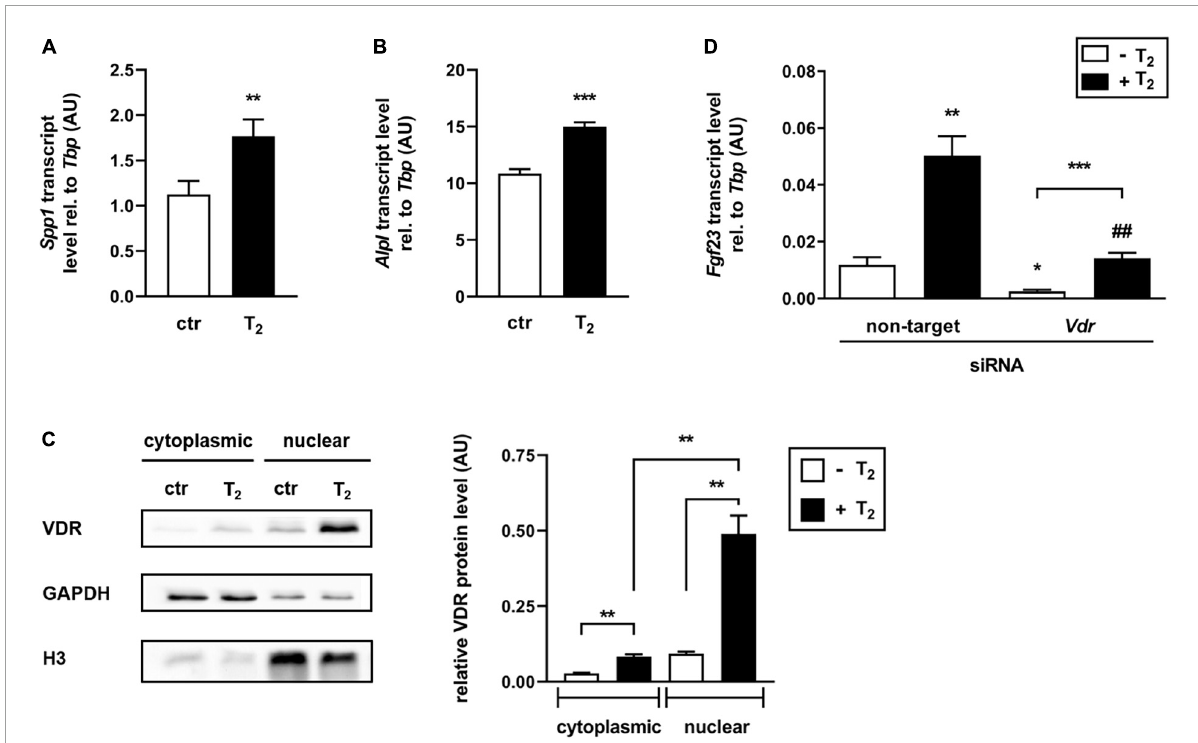
FIGURE3 The effect of tachysterol 2 on Fgf23 expression depends, at least in part, on regulation of the vitamin D receptor. Arithmetic means ± SEM of relative (rel.) Spp1 ( A n = 6) or Alpl ( B n = 5) mRNA abundance (normalized to Tbp ) in UMR106 cells treated with 25 µ M tachysterol 2 (T 2 ) for 24 h. (C) Original Western blots (left panel) showing cytoplasmic and nuclear VDR, GAPDH, and histone H3 (H3) protein abundance in UMR106 cells treated without (ctr) or with T 2 (25 µ M, 24 h). The right panel depicts the densitometric analysis (arithmetic mean ± SEM, n = 6) of cytoplasmic VDR (normalized to loading control GAPDH) and nuclear VDR (normalized to loading control histone H3) abundance in UMR106 cells treated without (white bars) or with (black bars) T 2 (25 µ M, 24 h). (D) Arithmetic means ± SEM of rel. Fgf23 mRNA abundance (normalized to Tbp ) in UMR106 cells incubated without (white bars) or with (black bars) T 2 (25 µ M, 24 h) in the presence or absence of non-targeting or Vdr -specific siRNA (100 nM, 48 h, n = 10). Treatment with Vdr -specific siRNA resulted in a 71% reduction of relative Vdr mRNA (D) expression compared to non-targeting siRNA as control. * p < 0.05, ** p < 0.01, and *** p < 0.001 indicate significant differences from control. ## p < 0.01 indicate a significant difference from the absence of Vdr -specific siRNA (2nd vs. 4th bar). AU, arbitrary units; ctr, control [ A Mann-Whitney U -test; B unpaired Student’s t -test; C , D Welch’s ANOVA